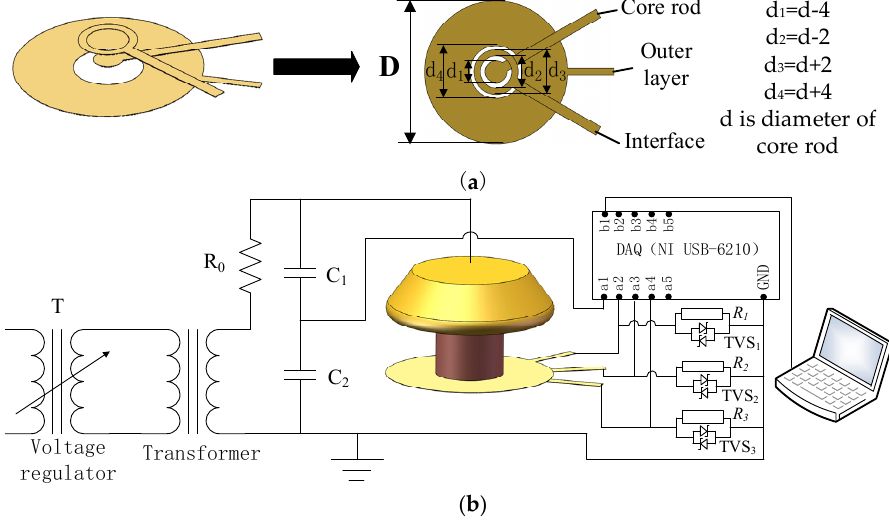
Figure 4. Improved current sensor: ( a ) The new lower electrode; ( b ) The new test circuit structure .